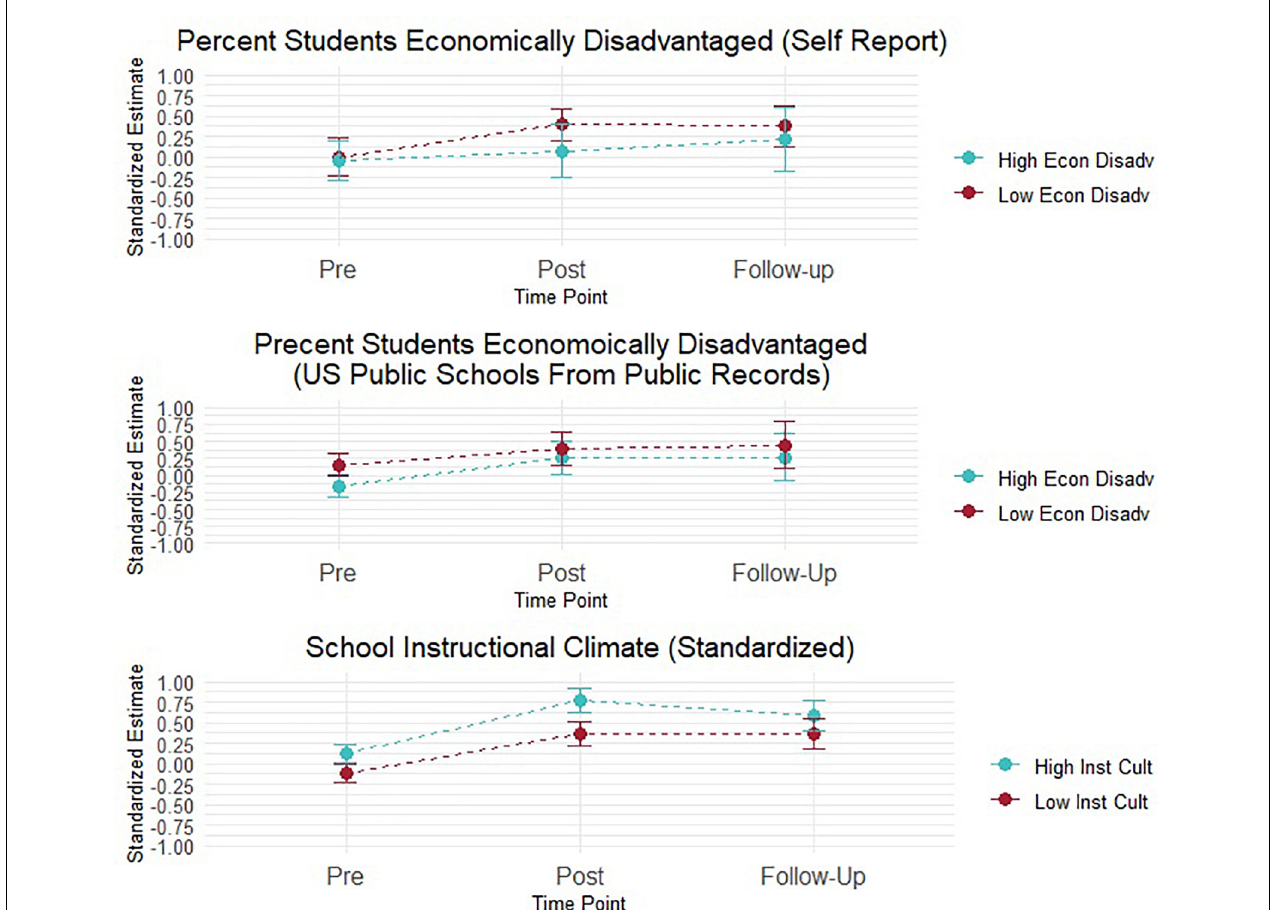
FIGURE 5 | Estimated change in practices from pre-survey average by economically disadvantaged students and school instructional